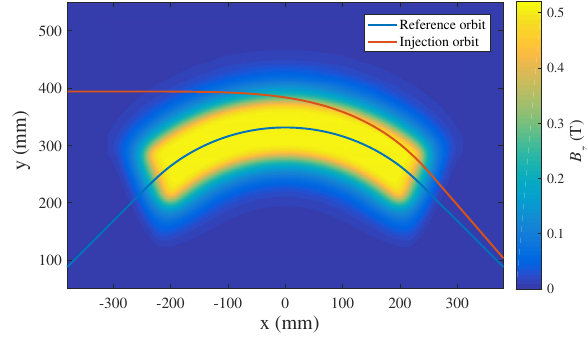
FIG. 10. Simulated beam